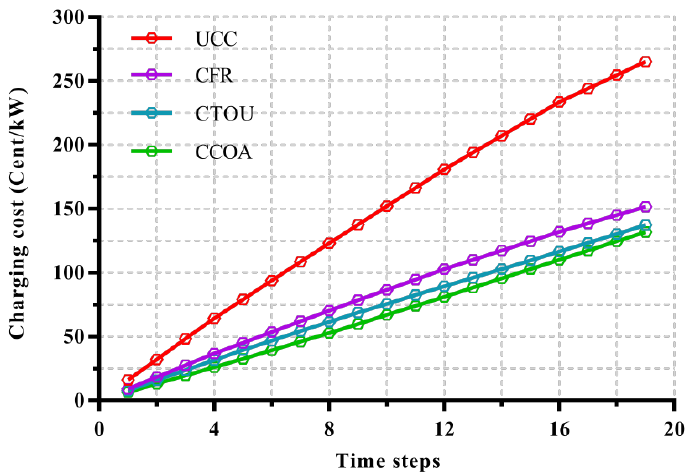
Figure 8. Charging costs concerning UCC, CFR, CTOU, and CCOA charging